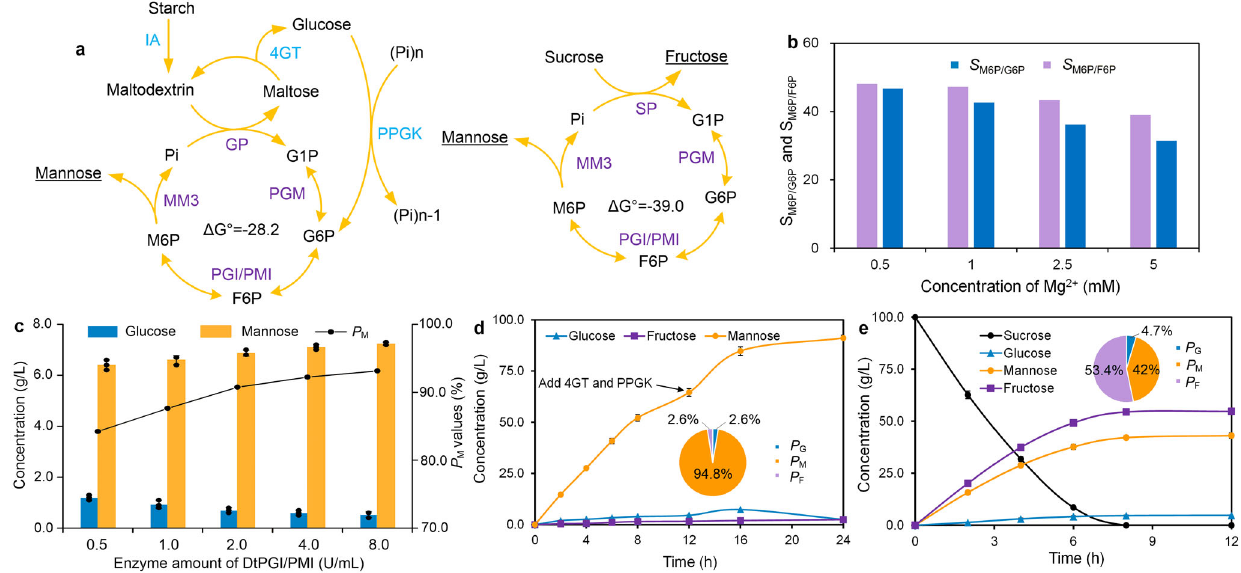
Fig. 6 Biosynthesis of mannose from starch and sucrose in multienzyme cascade systems. a Thermodynamically-driven manufacturing mannose from starch. b The effect of Mg 2 + concentration on S M6P/F6P and S M6P/G6P values of mutant MM3. c The effect of enzyme amount of DtPGI/PMI on mannose production and P M values. d Biosynthesis of mannose under 100 g/L of maltodextrin. The reaction medium containing 100 g/L of maltodextrin, 30 mM of PBS buffer, 1 mM of MgCl 2 , 10 U/mL of TmGP, 5 U/mL of TkPGM, 20 U/mL of DtPGI/MPI, and 10 U/mL of MM3 was carried out at 55 °C for 24 h. After reaction for 12 h, 5.0 U/mL of Tl4GT, 5.0 U/mL of TfPPGK, and 50 mM of hexametaphosphate were added to the reaction solution. e Biosynthesis of mannose under 100 g/L of sucrose. The reaction medium comprising of 100 g/L of sucrose, 20 mM of PBS buffer, 1 mM of MgCl 2 , 2.5 U/mL of BaSP, 5 U/ mL of TkPGM, 20 U/mL of DtPGI/MPI, and 10 U/mL of MM3 was carried out at 55°C for 12 h. Data are presented as mean values + / − SD ( n = 3 independent experiments). Source data for b – e are provided as a Source Data fi